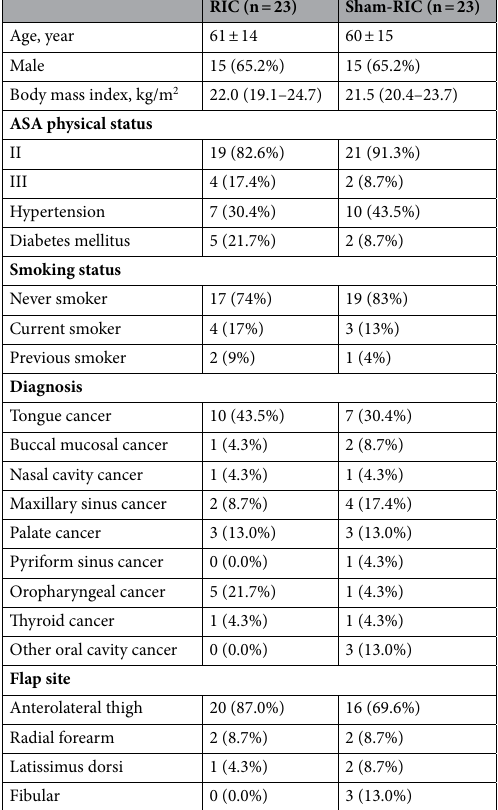
Table 1. Baseline characteristics of enrolled patients received remote ischemic conditioning or sham during free flap reconstructive surgery for head and neck cancer. Values are mean ± SD, number (proportion), or median (IQR). RIC remote ischemic conditioning, ASA American society of anesthesiologist.